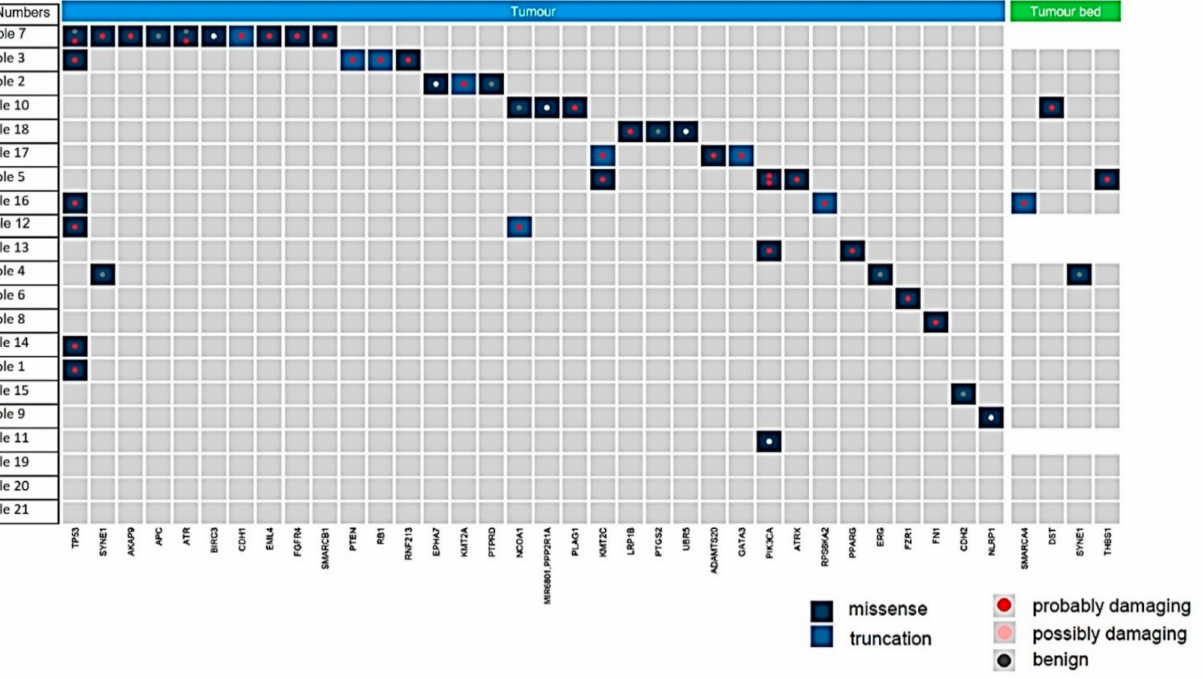
Figure 5. Summary of the mutations found in residual carcinoma (tumor, blue) and tumor bed (green). All mutations shown were detected at greater than 10% frequency of reads and are shown as missense (dark blue), truncating (light blue), and defined following the PolyPhen analysis as probably damaging (red dot), possibly damaging (pink dot) or benign (grey